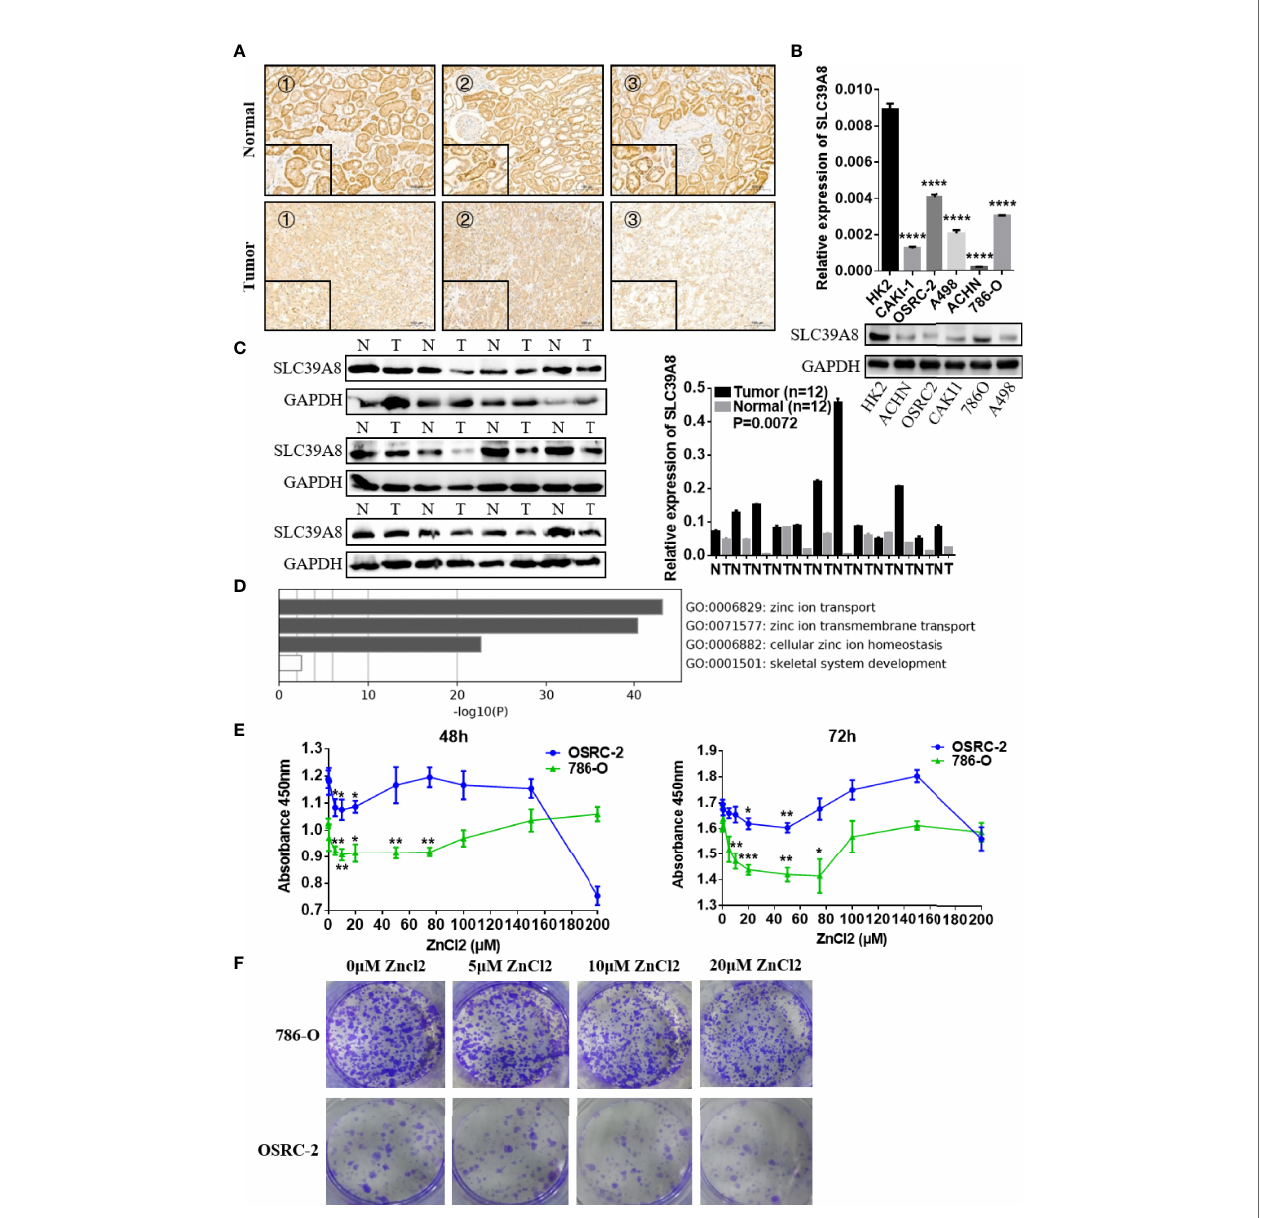
FIGURE 4 | Function of SLC39A8 and its expression in ccRCC samples and RCC cell lines. (A) Immunohistochemistry for SLC39A8 expression in ccRCC tissues and the corresponding normal tissues. The inserted images are the higher magni fi cation picture of a certain part of the same tissue, ×100 and ×400. (B, C) Reverse transcription-quantitative PCR assays and western blotting experiments of SLC39A8 expression in normal human renal epithelial cell line HK2 and RCC cell lines (786-O, OSRC-2, ACHN, A498 and CAKI-1) and ccRCC patients. (D) Functional enrichment analysis of ZIP family genes by Metascape. The results showed that ZIP family functions in the cellular import of zinc. (E) Cell proliferation assay of 786-O and OSRC-2 cells treated with different concentrations of zinc chloride (0 – 200 m M) for 48 – 72 h. (F) The colony formation assay of 786-O and OSRC-2 cells treated with 0 – 20 m M zinc chloride. The values of each group were presented as the mean ± standard deviation. *P <0.05, **P < 0.01, ***P < 0.001, ****P <